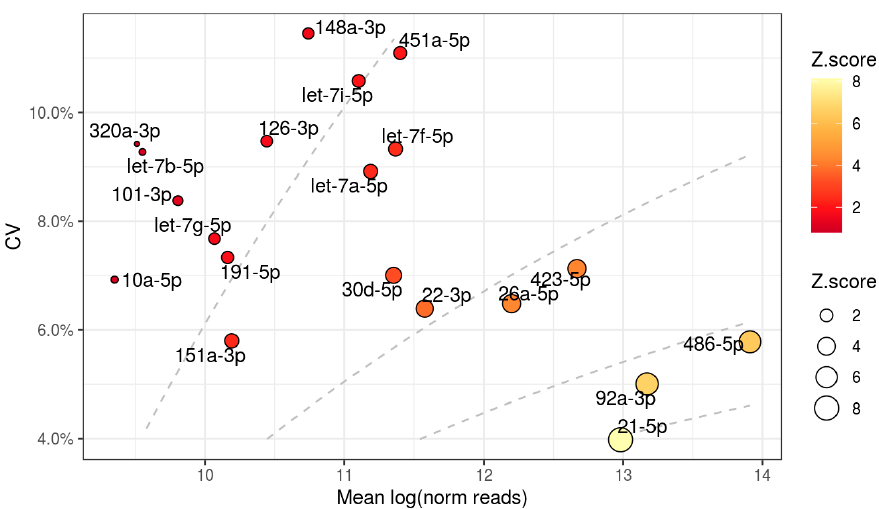
Figure 1. Relationship between abundance and variation of the 20 most stably expressed in plasma exosomes of healthy donors (HDs). Dashed lines represent two-unit intervals of Z-scores in the range 2 to 8 (top left to bottom right). CV: coefficient of variation.